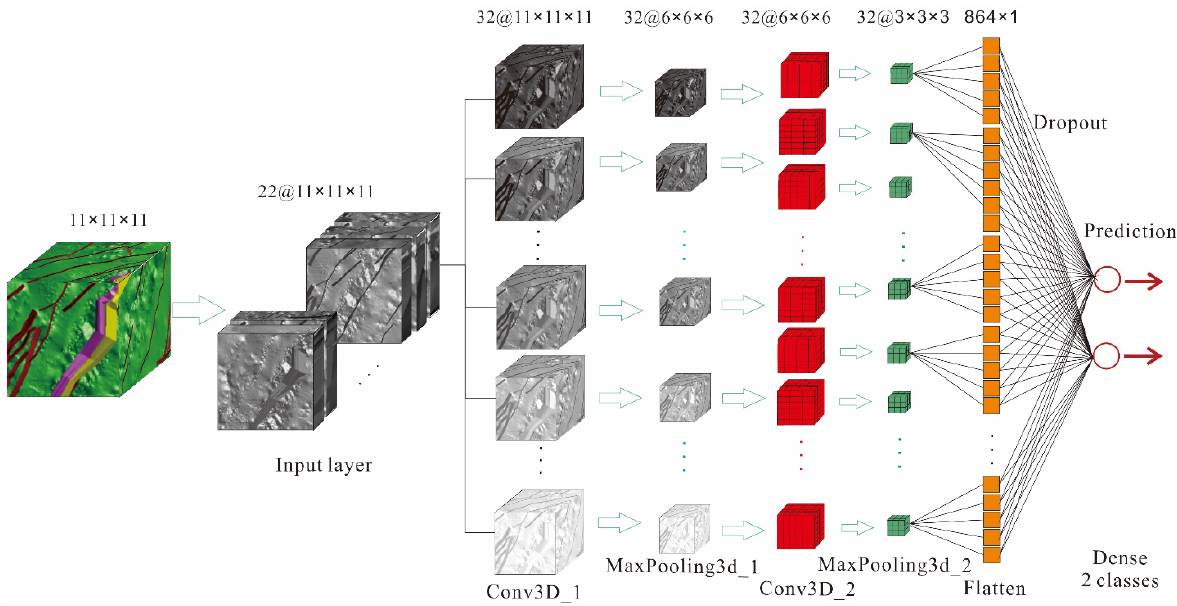
Figure 6. The structure of the 3D CNN prediction model. The first layer is the input layer with 22 voxels, and the size of the voxels is 100 m × 100 m × 100 m. Conv3D1 and Conv3D2 are convolutional layers, and the filter size of both layers is 5 × 5 × 5. MaxPooling3d1 and MaxPooling3d2 are 3D max-pooling layers with a pooling sizes of 2 × 2 × 2. Dropout is applied between the flatten layer and the dense layer, and the fraction of the input units to drop is set to 0.5. Note that the regularization method is applied on the dense layer.